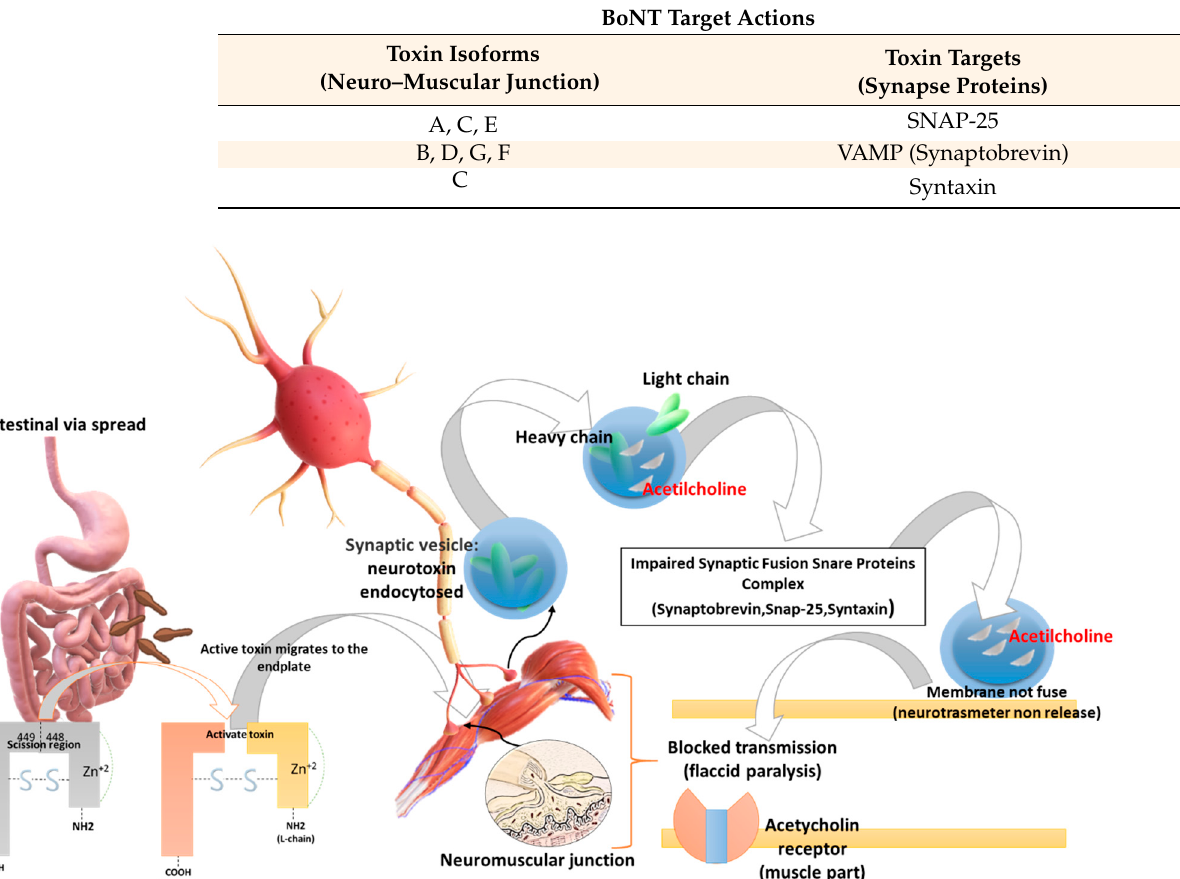
Figure 1. Biomolecular mechanism of toxin action: BoNTs (a) have tropism for peripheral motor neurons, (b) cut the SNAP 25 protein, (c) inhibit synaptic vesicle fusion with the presynaptic membrane, (d) inhibit the release of the neurotransmitter acetylcholine at the level of the neuromuscular plate causing flaccid paralysis and death from respiratory arrest. BoNTs (e.g., BoNT-A) initially are activated in the digestive system by the action of the trypsin (a serine protease) in the scission region (449–448) and are therefore absorbed by the gut. BoNTs spread in the blood until they reach the neuromuscular and cholinergic junctions, penetrate the synaptic cholinergic endings, and block the release of acetylcholine, causing flaccid paralysis. The heavy chain of the toxin is important for its penetration into the axonic extremities, a condition to which the onset of paralysis is linked. Following the binding of the heavy chain to terminal axon proteins, the toxin can enter neurons via endocytosis. The binding of the heavy chain occurs with the protein receptor SV2, whose expression is increased when the synapse is most active. The light chain is able to leave the endocytic vesicles and reach the cytoplasm. The light chain of the toxin possesses protease activity. Toxin A proteolytically degrades SNAP-25 protein, a type of SNARE protein. The SNAP-25 protein is necessary for the release of neurotransmitters from terminal axons (in particular, botulinum toxin degrades SNAREs, preventing the release of neurotransmitters at the synapse level). Credits: Original figure by I.A. Charitos.